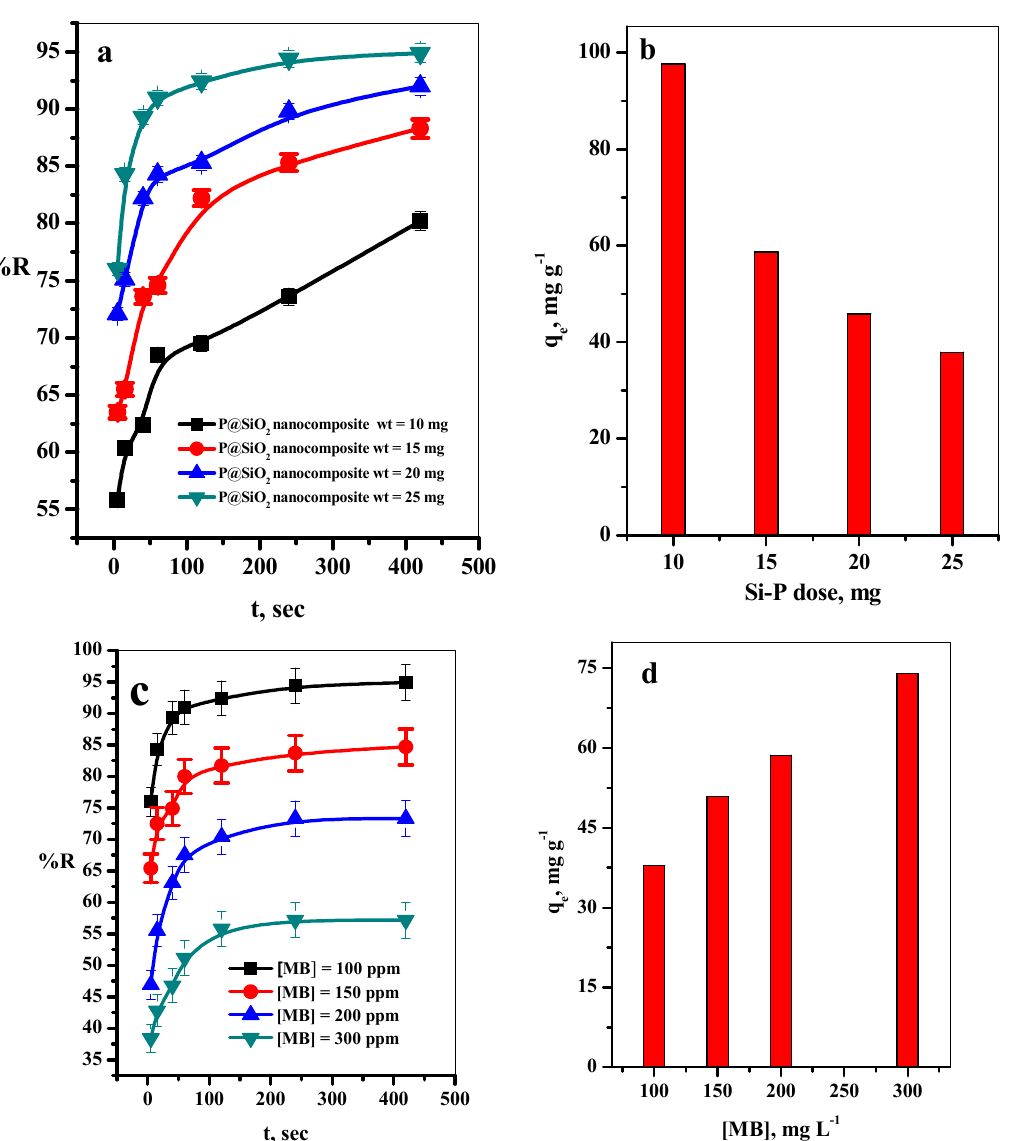
Figure 3. Effect of ( a ) P@SiO 2 nanocomposite doses at the different contact times, ( b ) effect of P@SiO 2 nanocomposite doses on q e values, ( c ) effect of initial MB concentrations at the different contact time, and ( d ) its effect on q e values, on the adsorption of MB dye. (P@SiO 2 dose ([MB] = 100 mg/L/10 mL, pH = 7, T = 25 °C) and ( d ) initial MB concentrations ([P@SiO 2 ] = 25 mg/10 mL, pH = 7, T = 25